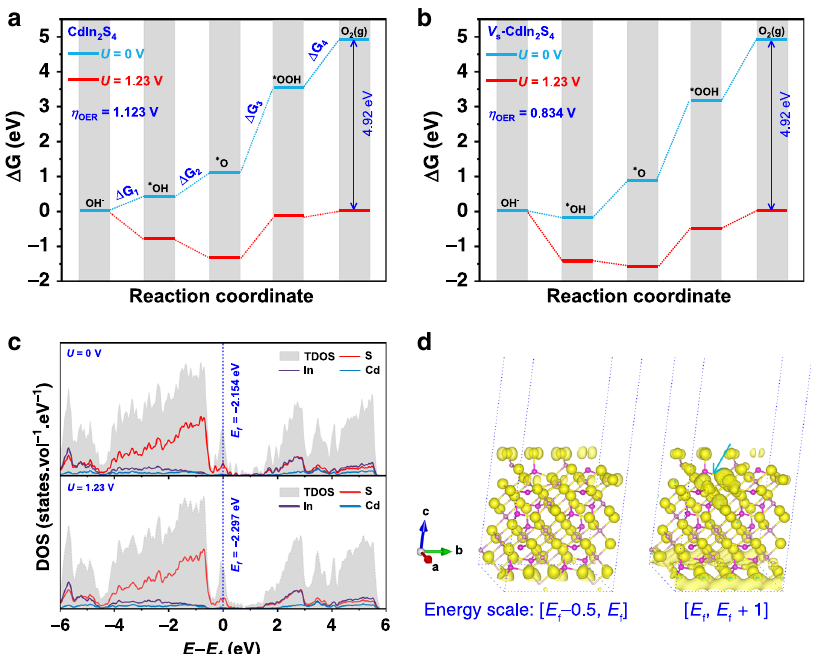
Fig. 5 OER mechanism for the CdIn 2 S 4 photoanode. a Free energies of OER steps for CdIn 2 S 4 (011). b Free energies of OER steps for V s -CdIn 2 S 4 (011). c Comparison of density of states for V s -CdIn 2 S 4 (011) without applied bias and with an applied bias of 1.23 V. d Photoexcited charge-transition route change for V s -CdIn 2 S 4 (011) from HOMO states (in the range of 0 – 0.5 eV below the Fermi level) to LUMO states (in the range of 0 – 1 eV above the Fermi level) with an applied bias of 1.23 V (isosurface set at 0.004e Bohr − 3 ). The charge difference density is calculated by Δ ρ = ρ 1.23V − ρ 0V , and the yellow region represents electron